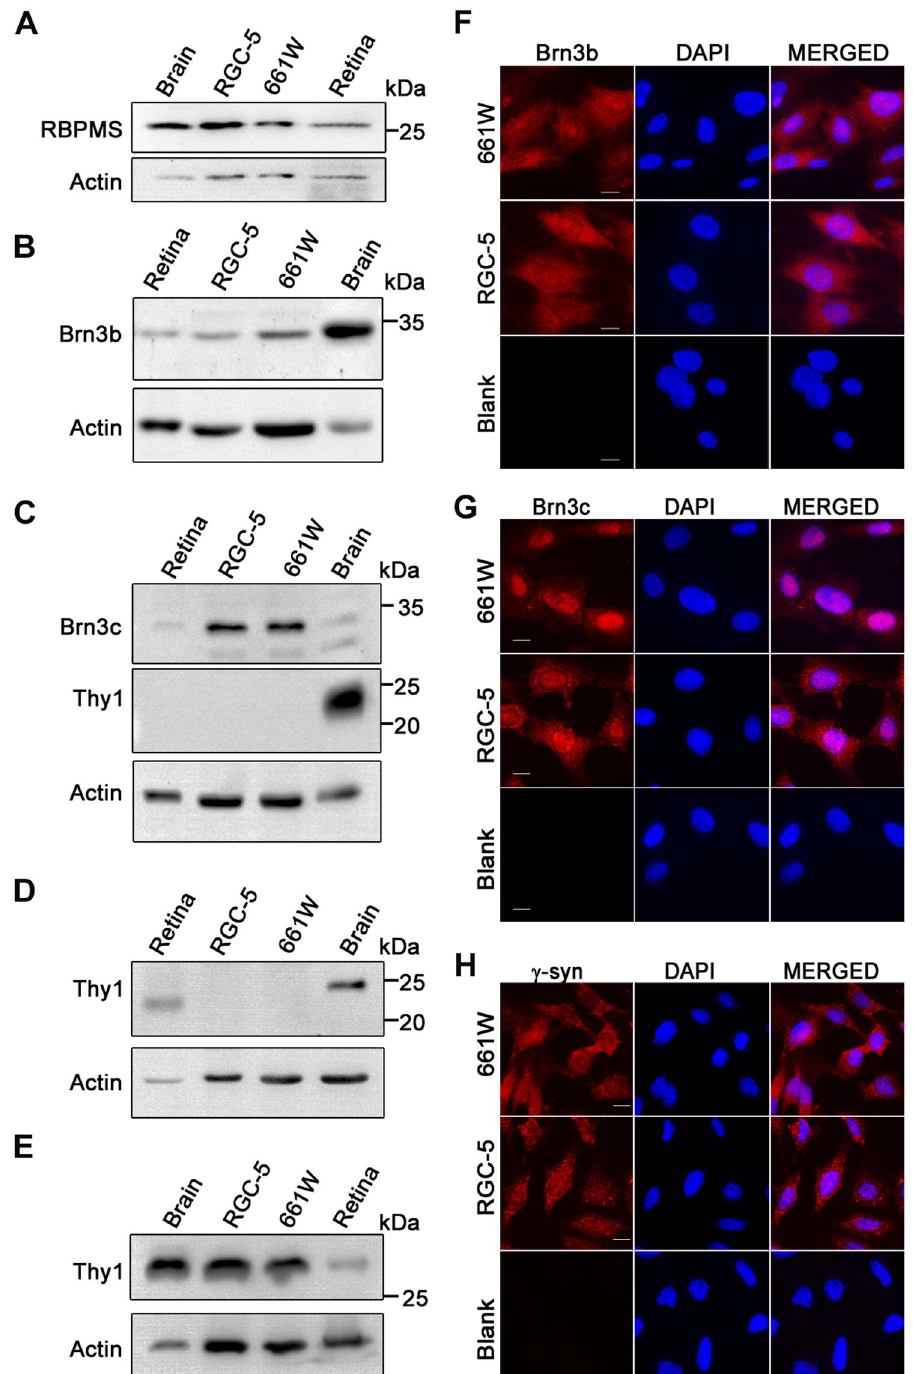
Figure 1. Expression of RGC-specific markers in 661W cells. 661W and RGC-5 cell lysates were subjected to western blotting for the expression of RBPMS ( A ), Brn3b ( B ), Brn3c ( C ) and Thy-1 ( C , D and E ). For Thy1 three different antibodies sourced from CST ( C ), R & D systems ( D ) and Santa Cruz ( E ) were used. Mouse retina and brain were used as positive controls. Immunofluorescence staining of 661W and RGC-5 cells for Brn3b ( F ), Brn3c ( G ) and γ Synuclein ( H ) is shown. Staining of nuclear DNA with DAPI is shown in blue. Blank indicates negative control where cells were processed similarly without addition of primary antibody. Panels show images captured using a fluorescence microscope at 40X magnification. Scale bar, 10 µ